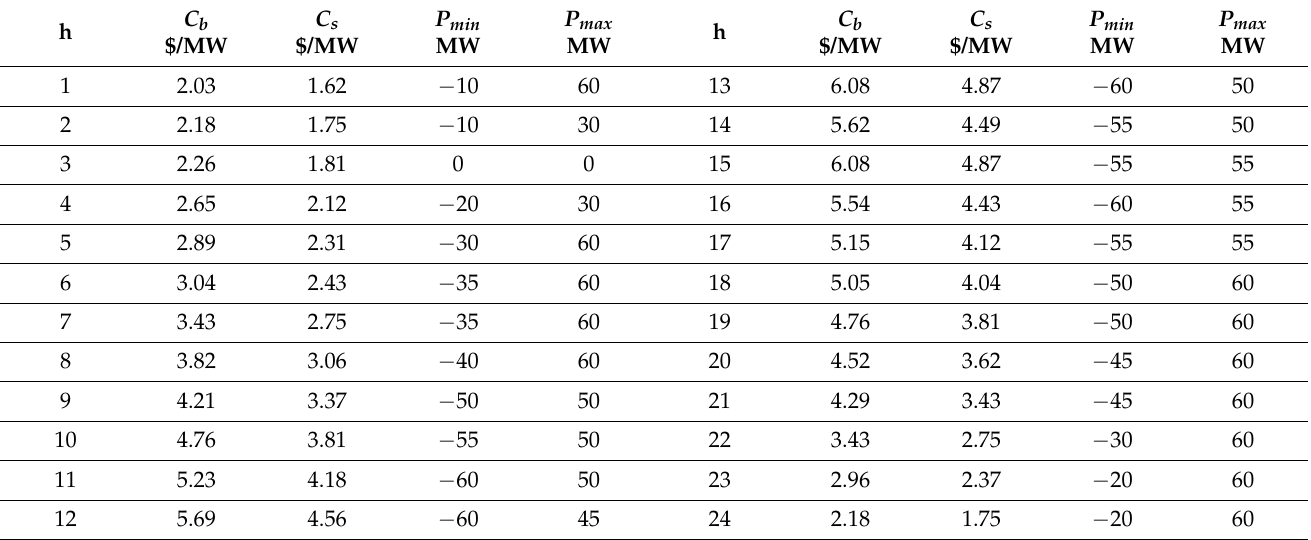
Table 3. Utility sale and purchase rate for 24 h.